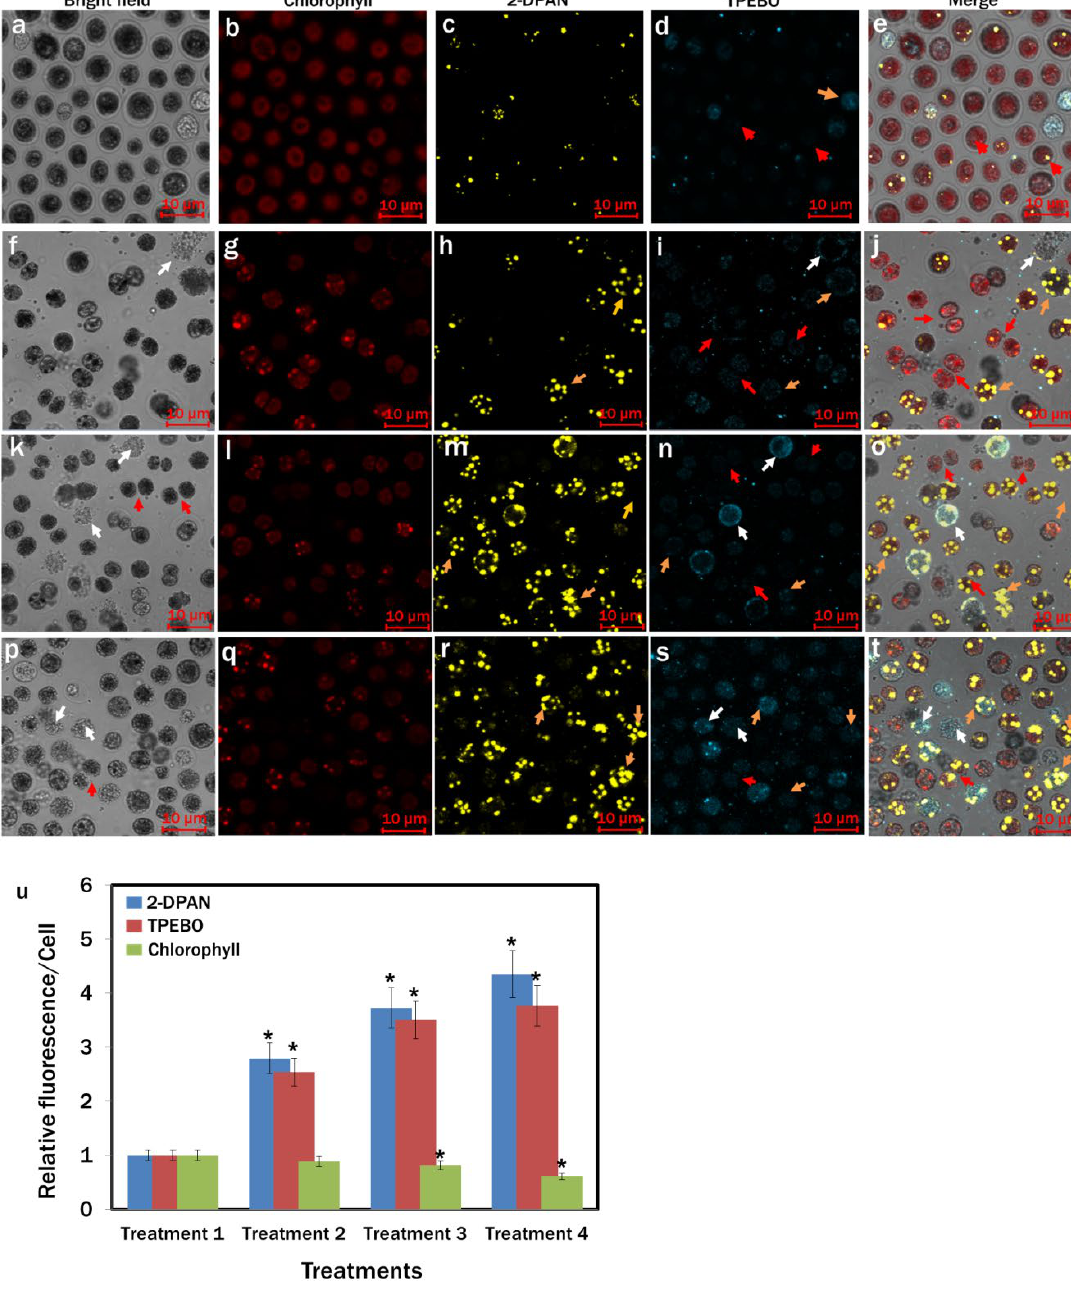
Figure 7. Confocal images of H 2 O 2 activities in Chlamydomonas reinhardtii cells during lipid induction. H 2 O 2 and lipid drops were labelled with AIE-probes, TPE-BO (100 µM; incubation-15 min) and 2-DPAN (20 µM; incubation-30 min), respectively. ( a – e ) Treatment 1: modified Woods Hole (MBL) medium; ( f – j ) Treatment 2: MBL, ( − ) N 2 ; ( k – o ) Treatment 3: MBL, ( − ) N 2 , ( − ) Ca 2+ ; ( p – t ) Treatment 4: MBL, ( − ) N 2 , ( − ) Ca 2 + , (+) sodium acetate (2.0 g/L) (all the treatments were in 24 hr light condition). Bright-field images: a, f, k and p; Fluorescence images— Chlorophyll: b, g I and q (λ ex : 488 nm, λ em : 685 − 758 nm); 2-DPAN: ( c , h , m , r ) (λ ex : 488 nm, λ em : 570–650 nm); TPE-BO: ( d , i , n , s ) (λ ex : 405 nm, λ em : 428-499 nm); Merged image: ( e,j , o ,) and ( t , u ) Relative fluorescence intensity/cell for different treatments. The red arrow indicates H 2 O 2 activity in normal cells and during cell division; the orange arrow indicates H 2 O 2 activity in lipid accumulated cells; The white arrow indicates H 2 O 2 activity in autophagic cells. Averages are shown as mean ± SE; * p < 0.05; Images were taken with Zeiss LSM 880 Airyscan confocal